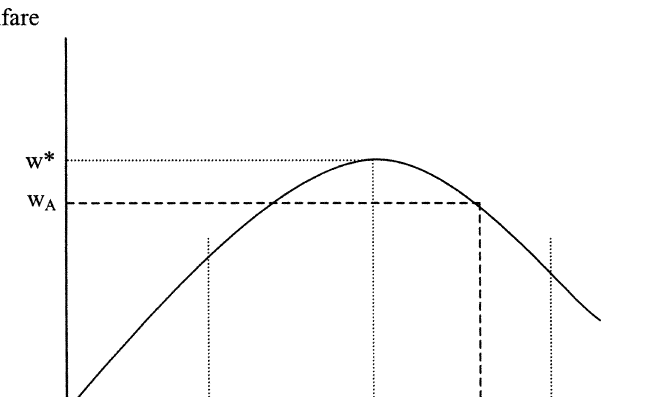
FIGURE 1 THE WELFARE-PROTECTION